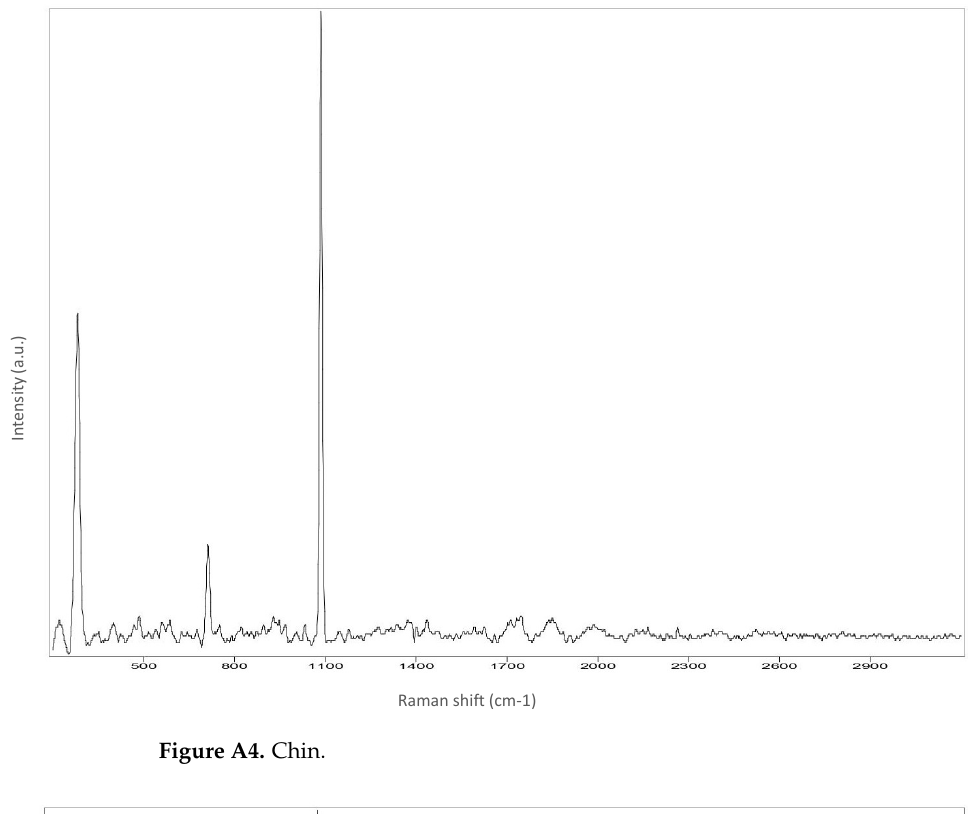
Figure A4. Chin. Figure A4. Chin.